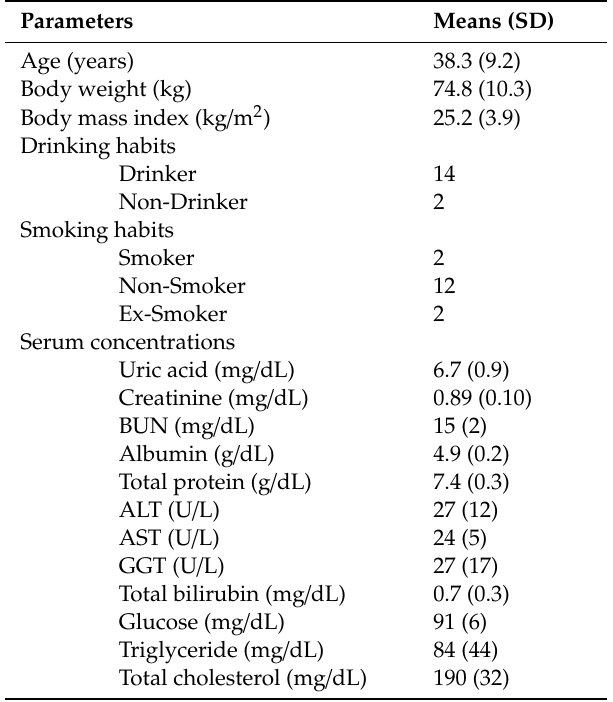
Table 2. Characteristics of the healthy male volunteers ( n =